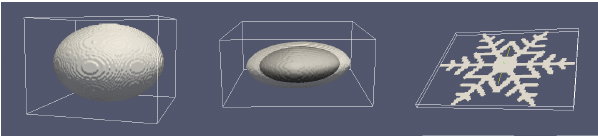
Figure 6. Particle shape models used in DDScat: oblate ellipsoid for raindrops (left); two concentric ellipsoids for melting ice parti- cles, with an ice core and a water shell (middle); dendritic shape for pristine ice particles (right).